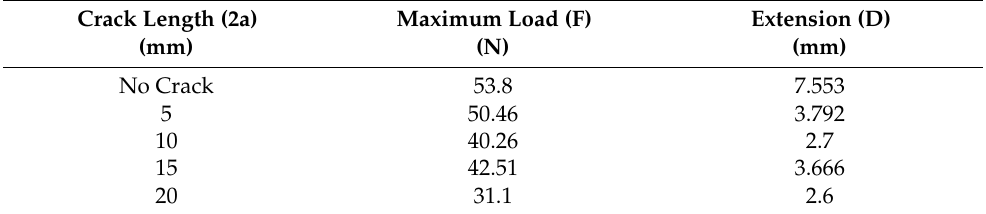
Figure 8. Load vs. displacement of Al foil/LDPE with a center crack of 0–20 mm. Table 3. Peak load and maximum displacement of fractured Al foil/LDPE, thickness B of 40 µ m and dimensions of 230 mm × 95 mm.